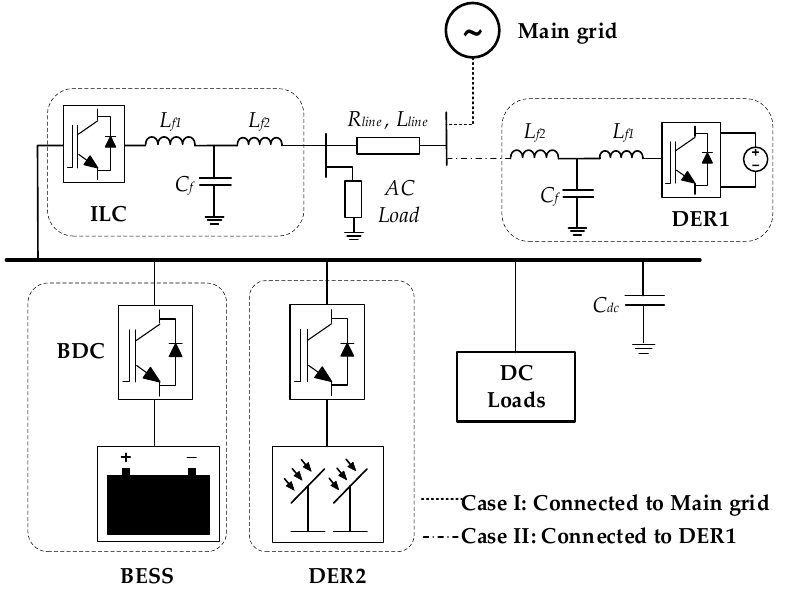
Figure 3. Hybrid microgrid under the study.